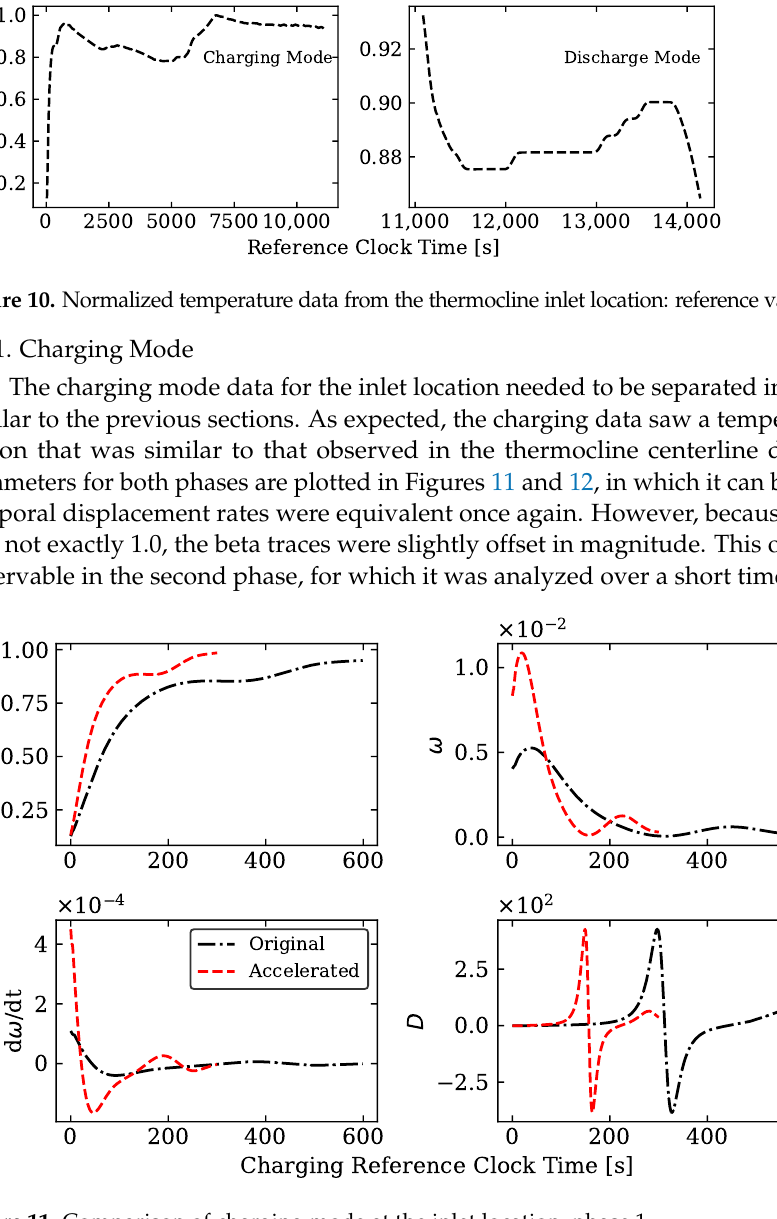
Figure 11. Comparison of charging mode at the inlet location, phase